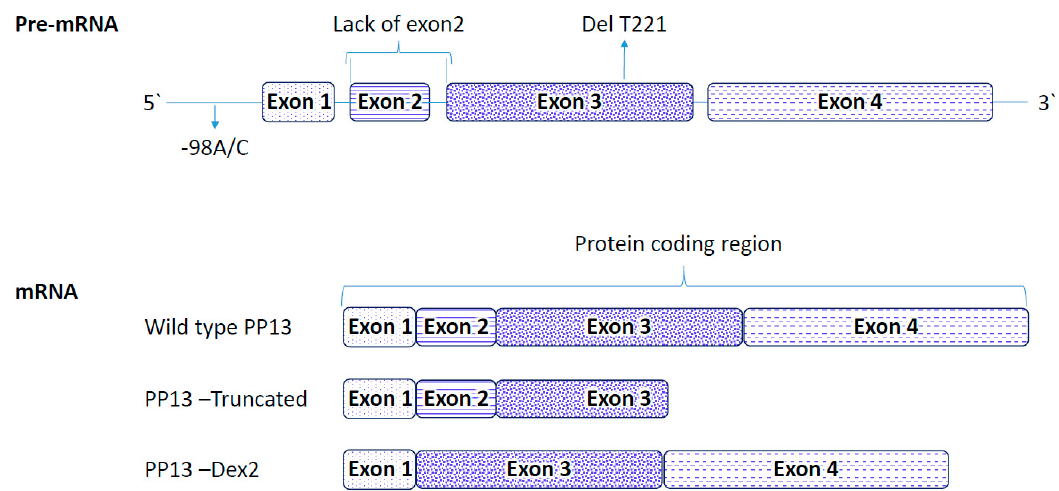
Figure 1. Schematic diagram of the LGALS13 gene and its mRNA variants. Top—The exons and introns are marked by boxes and lines, respectively. Lower panels represent the mRNA and the protein coding region. The wild type Gal-13 (PP13) consists of four full exons. The truncated Gal-13 variant delT 221 is missing part of exon 3 and the full exon 4, while the Dex-2 variant is missing exon 2. The two variants—the truncated delT 221 variant and the spliced variant Dex-2 are both naturally occurring variants along with the promoter polymorphic variant of -98 A/C.